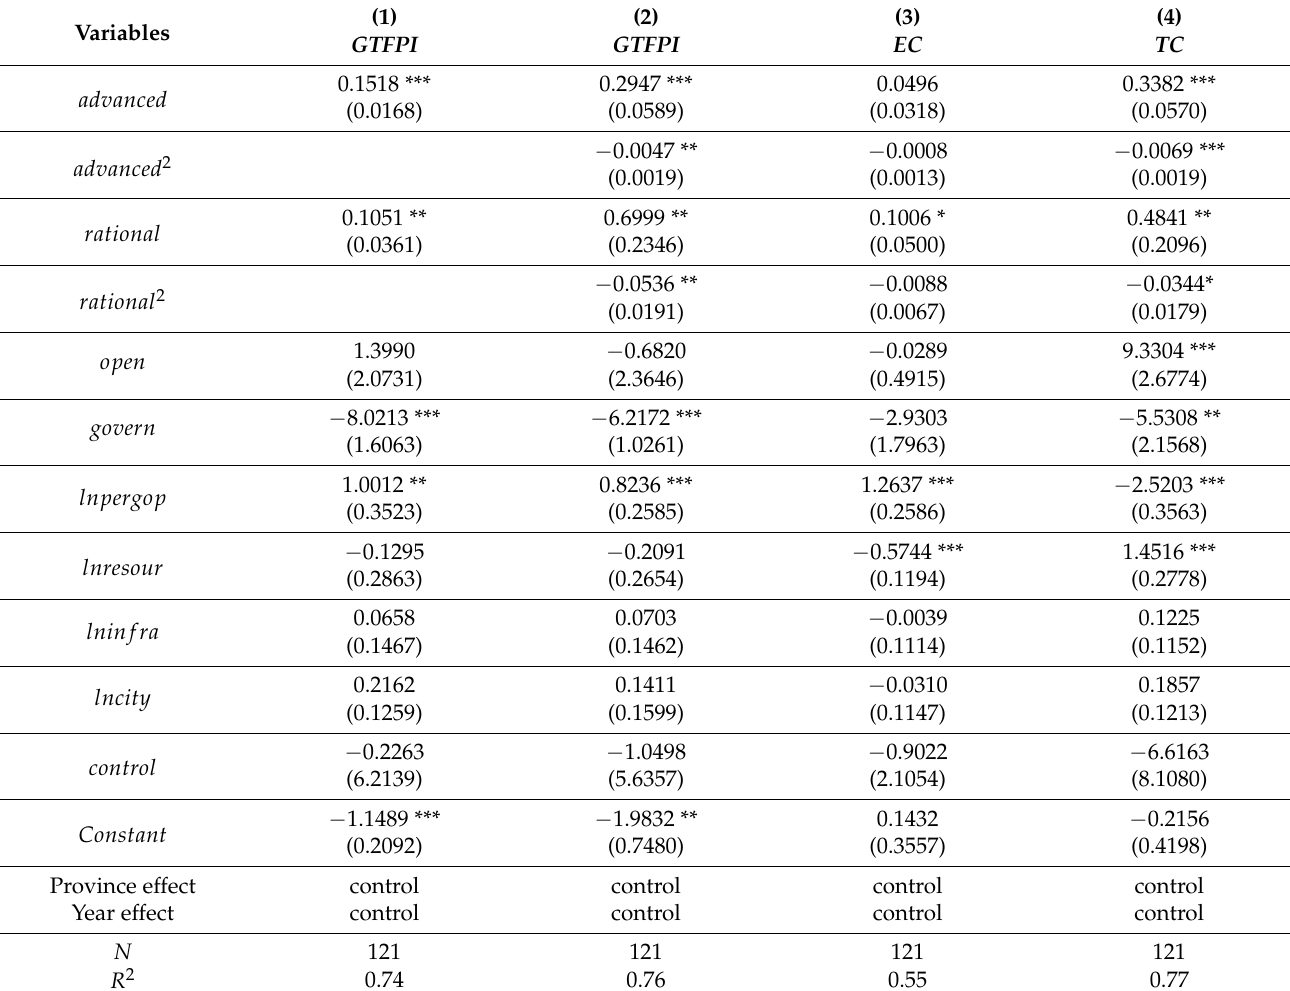
Table 2. Empirical Results of Marine Industrial Structure Evolution on Marine Economic